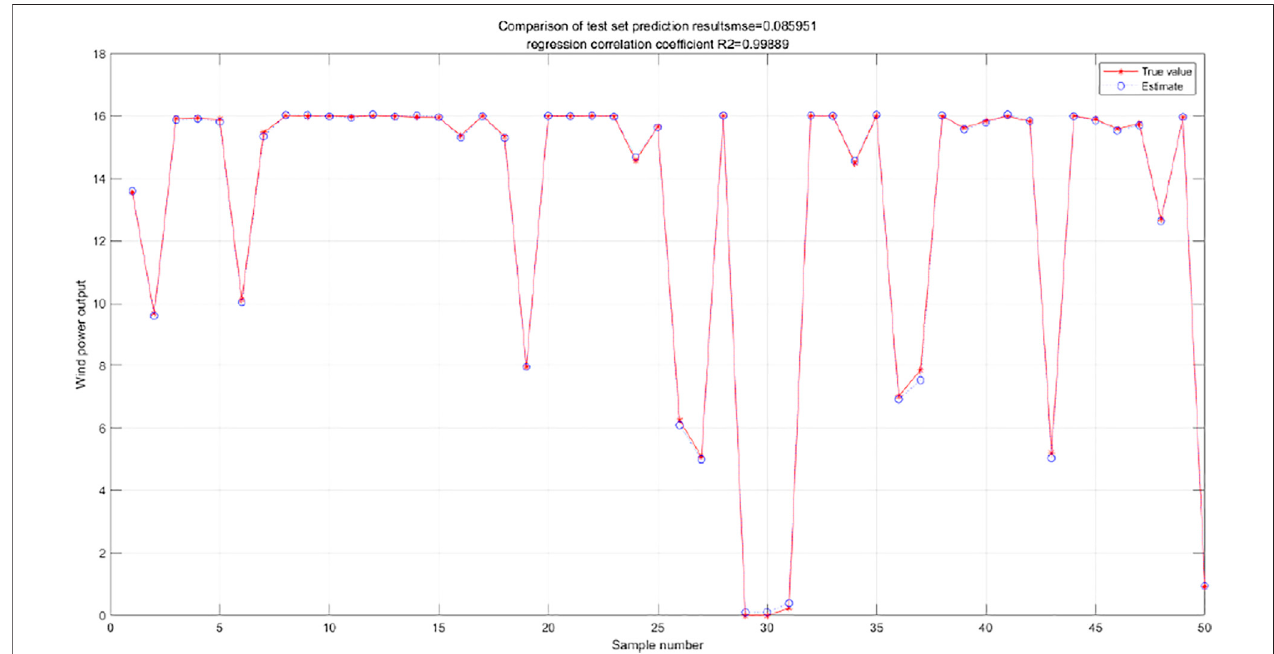
FIGURE 8 | Comparison of BP neural network